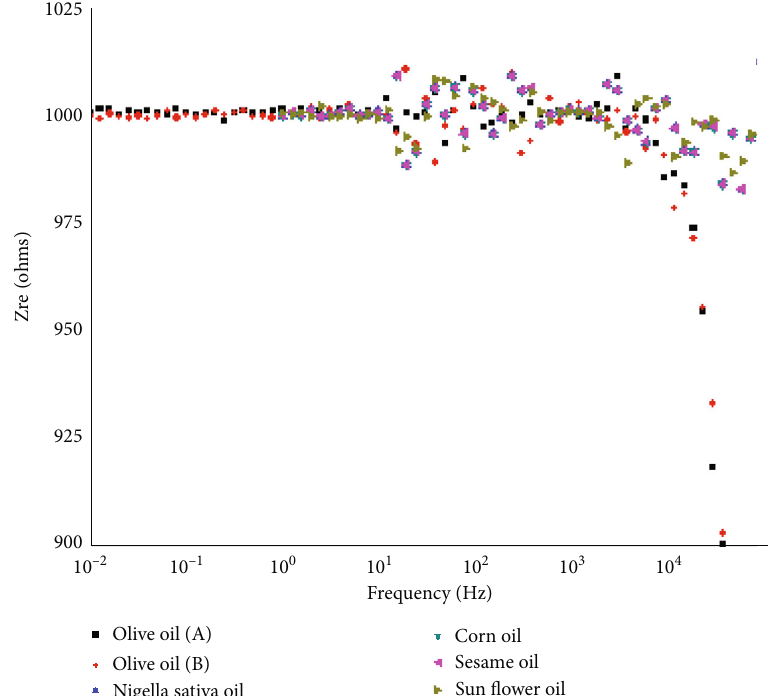
Figure 3: Frequency dependence of the real part of the impedance for all samples.